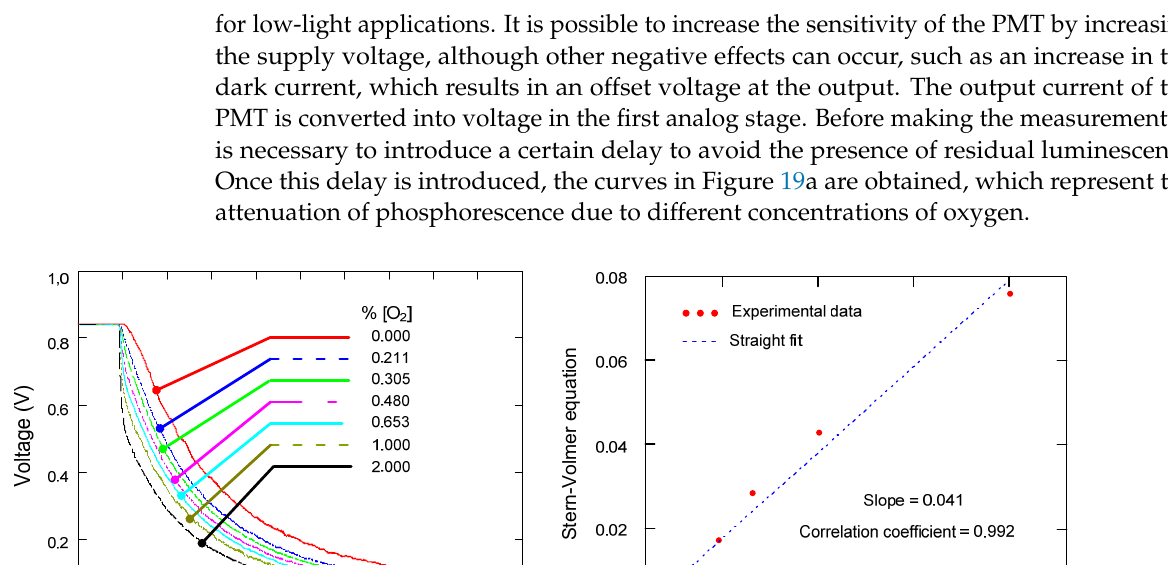
Figure 18. Design of an optical oxygen sensor based on phosphorescence lifetime measurements.